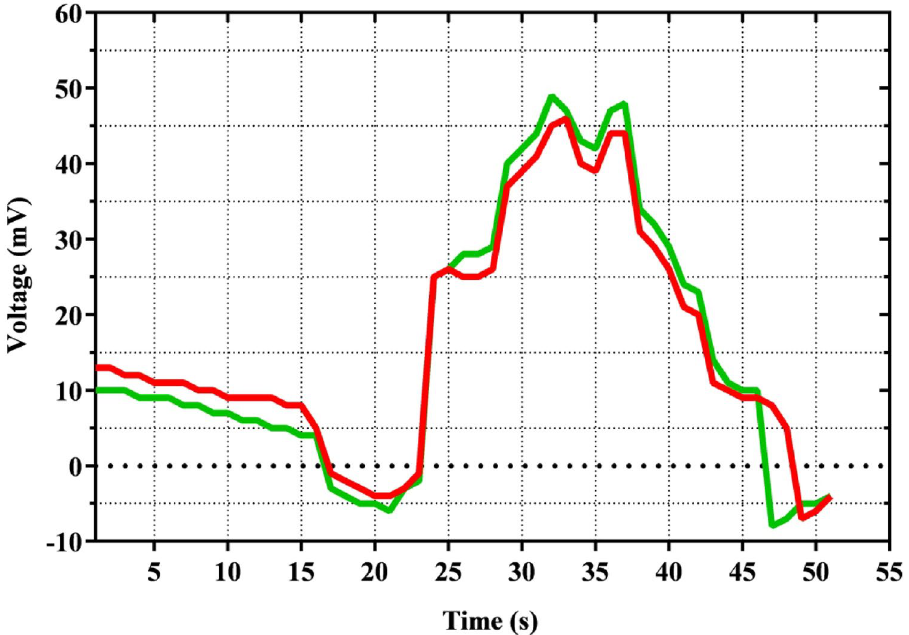
Figure 5. The plot indicates the change in charge in relation to time (s) due to Eristalis tenax (red) and Cheilosia albipila (green) landing. It is the mean charge variation in relation to the time of flies landed on e-flowers 23 s ( E. tenax ) and 21 s ( C. albipila ) at which the voltage or charge